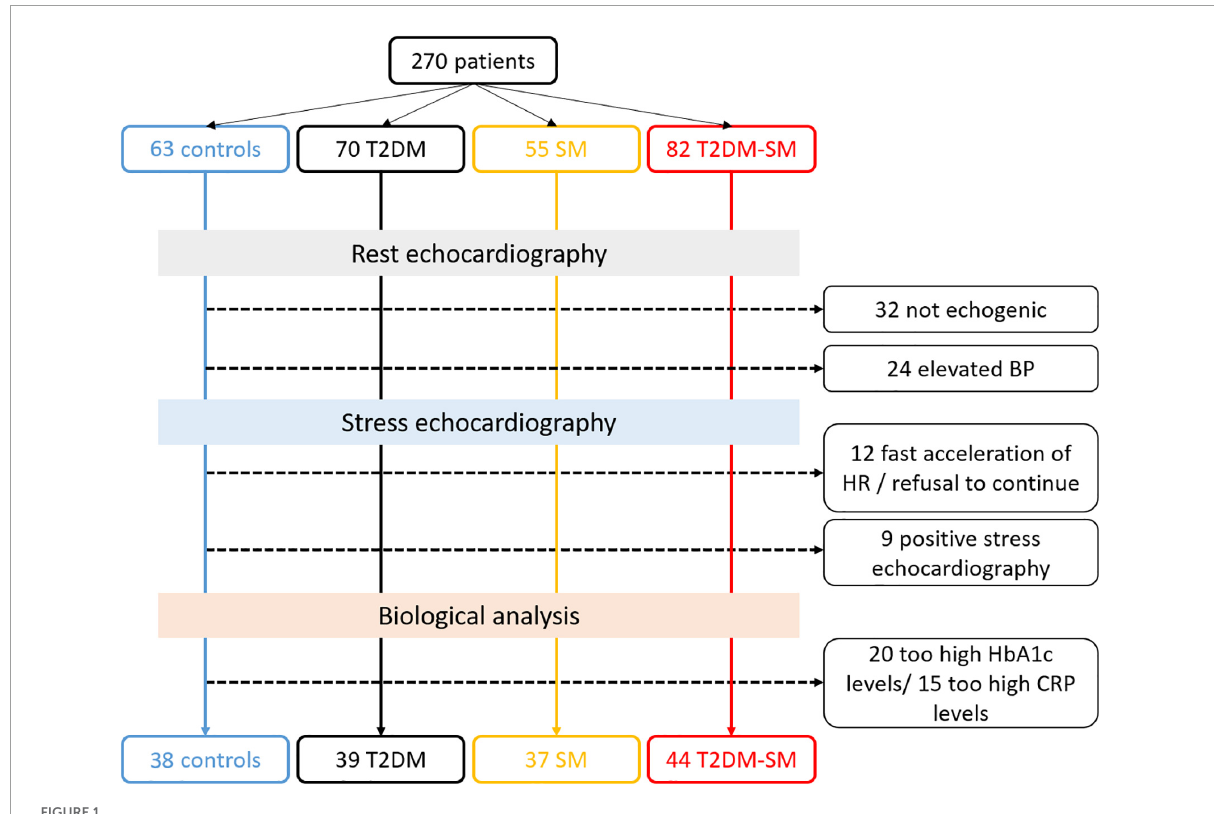
FIGURE1 Flow chart of patient recruitment with exclusion criteria